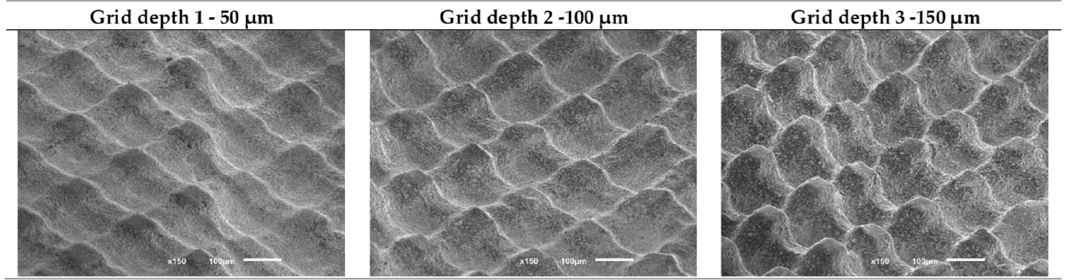
Figure 8. Images of surface topology by scanning electron microscopy.